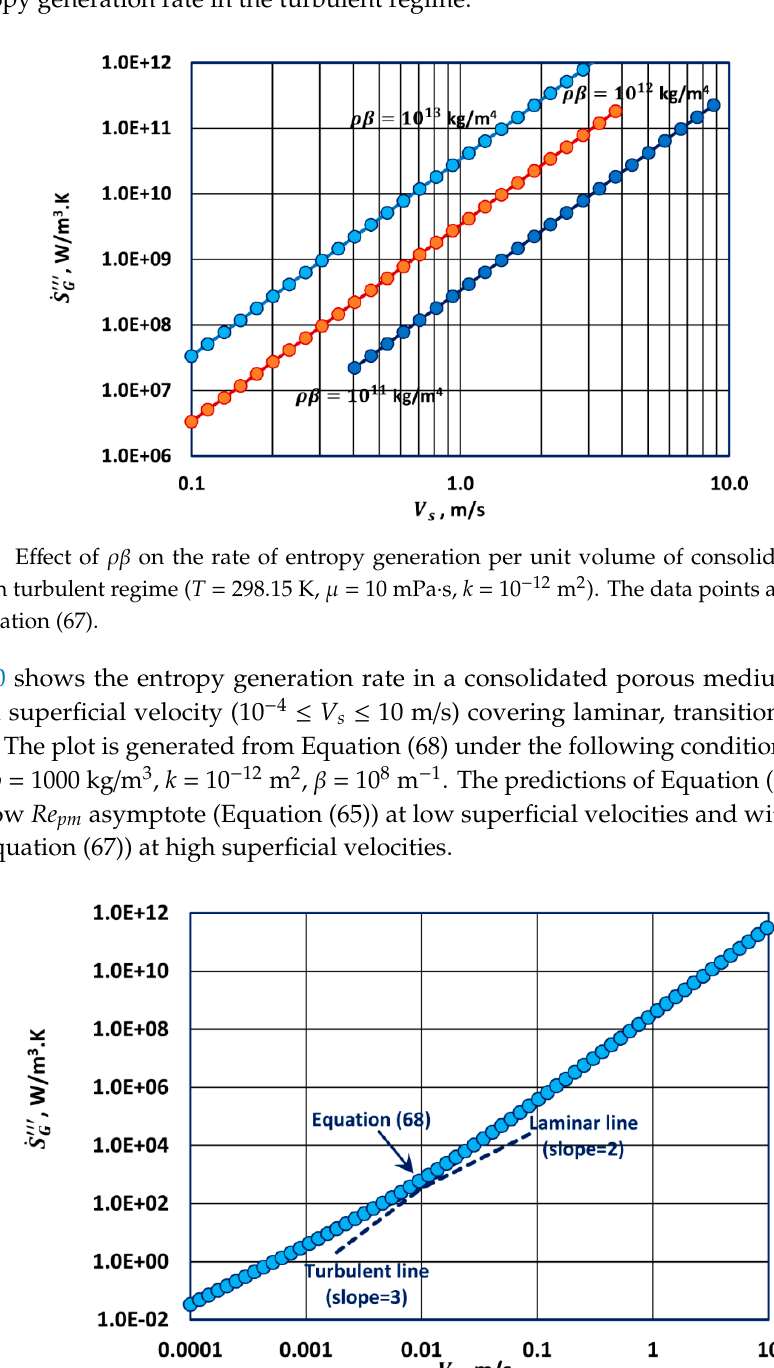
19 of 22 Figure 18. Effect of viscosity to permeability ratio ( (cid:2020) (cid:1863)⁄ ) on the rate of entropy generation per unit volume of consolidated porous medium in laminar flow ( (cid:1846) = 298.15 K, (cid:2010) = 10 8 m − 1 , (cid:2025) = 10 3 kg/m 3 ). The data points are generated using Equation (65). In turbulent flow through consolidated porous medium, the key factor governing the (cid:1845)(cid:4662) (cid:3008)(cid:4593)(cid:4593)(cid:4593) vs. (cid:1848) (cid:3046) behavior is (cid:2025)(cid:2010) where (cid:2010) is the non-Darcy flow coefficient. With the increase in (cid:2025)(cid:2010) , the entropy generation rate increases at any given (cid:1848) (cid:3046) , as shown in Figure 19. Note that the non-Darcy flow